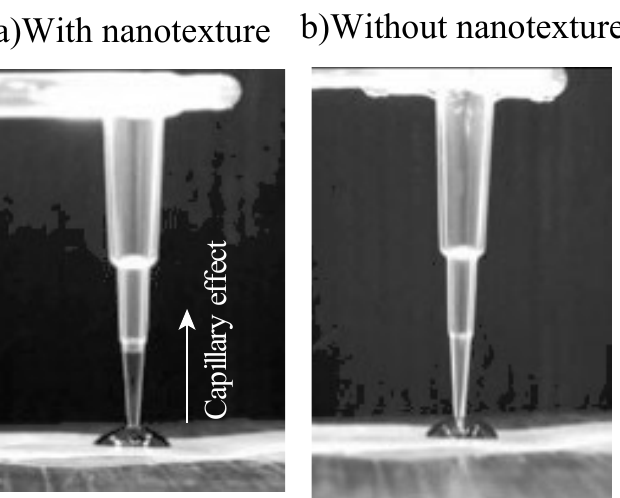
Figure 7. ( a ) Photographs of the replicated plastic pipettes with the nanotexture at the tip and ( b ) the replicated plastic pipettes without the nanotexture at the tip.